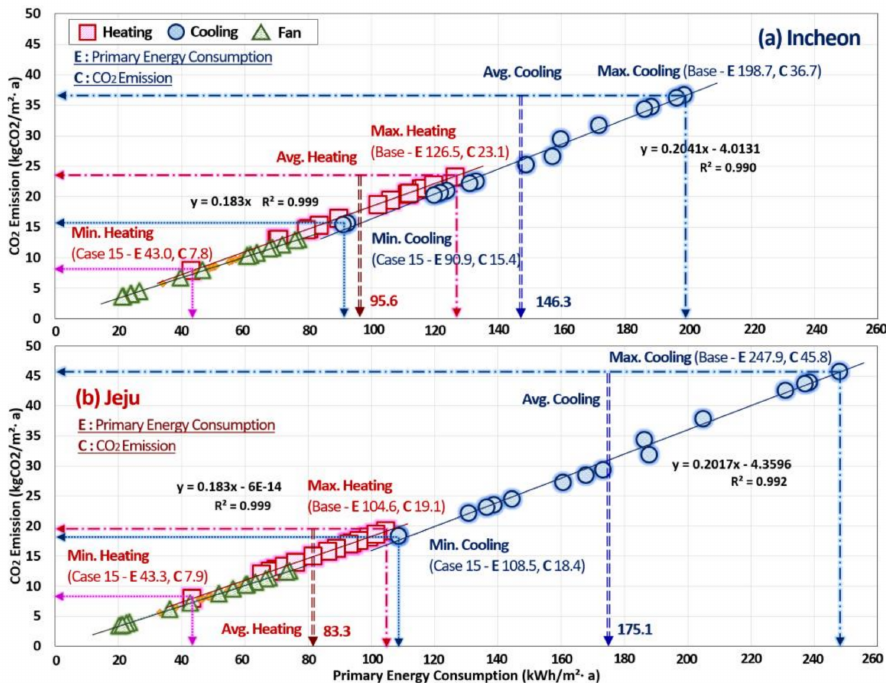
Figure 21. Correlation between primary energy consumptions and CO 2 emissions in ( a ) Incheon and ( b )